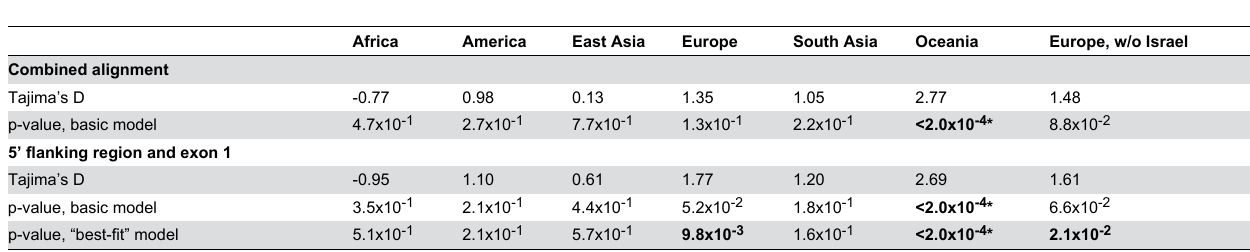
Table 1. Selection test results of six studied populations estimated using TYR re-sequencing